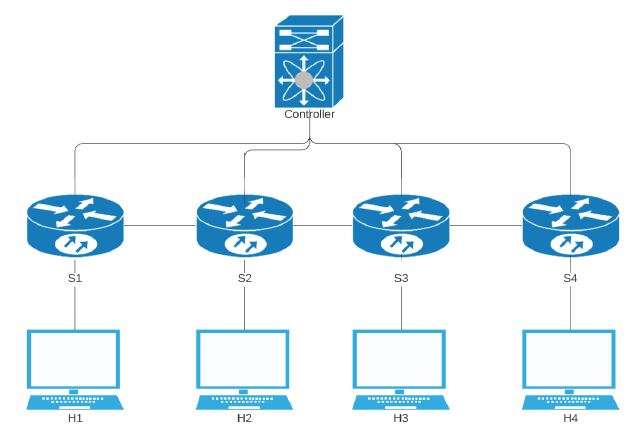
Figure 2. Linear